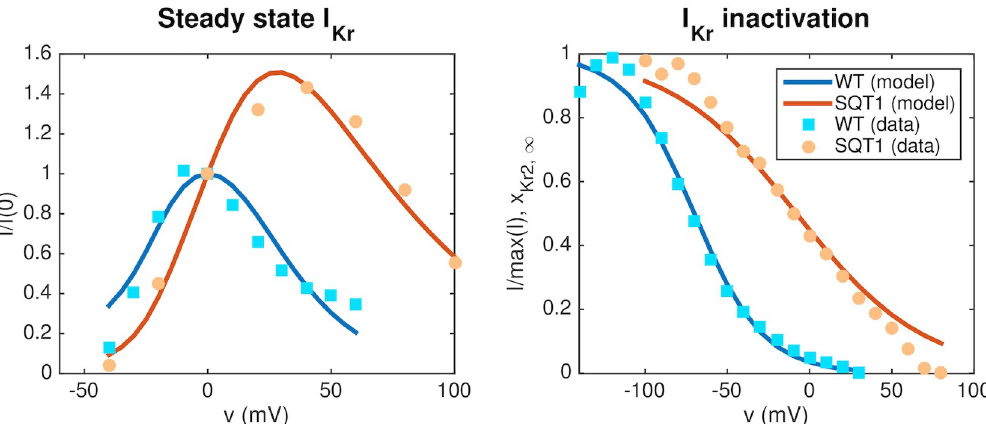
Fig 5. Representation of the SQT1 mutation N588K in the I Kr model. Left panel: Steady state I Kr currents obtained at different fixed values of the membrane potential divided by the currents obtained at v = 0 mV. The results obtained for the fitted WT and SQT1 I Kr models are compared to corresponding data from [14]. Right panel: Comparison of the steady state inactivation gate in the WT and SQT1 models of I Kr and steady state inactivation data from [14]. In the SQT1 case, the inactivation is shifted towards higher values of the membrane potential. Data used in this figure can be found in S1 Data.